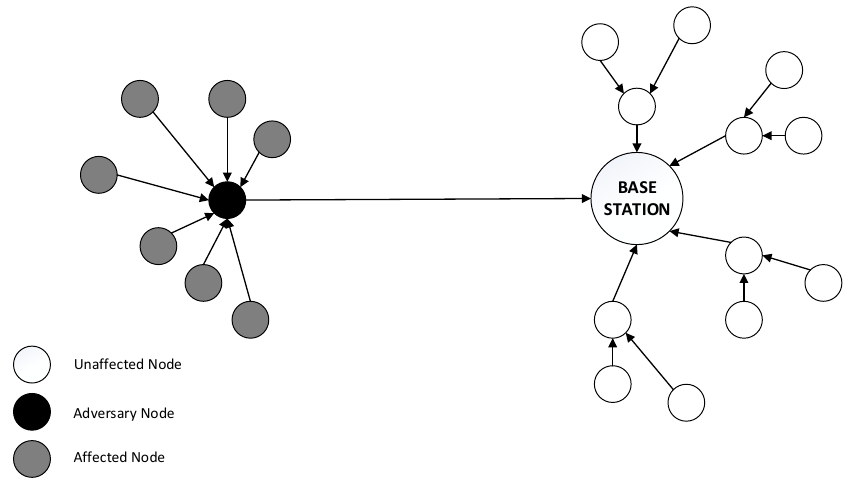
Figure 4. Demonstration of a Sinkhole Attack. Blackhole Attack: In this attack, the malicious node identifies itself as the closest node to the base station and collects data from neighboring sensor nodes to be transmitted to the base station. The purpose of the malicious node is that the collected data does not reach the base station. Figure 5 shows the illustration of a Blackhole